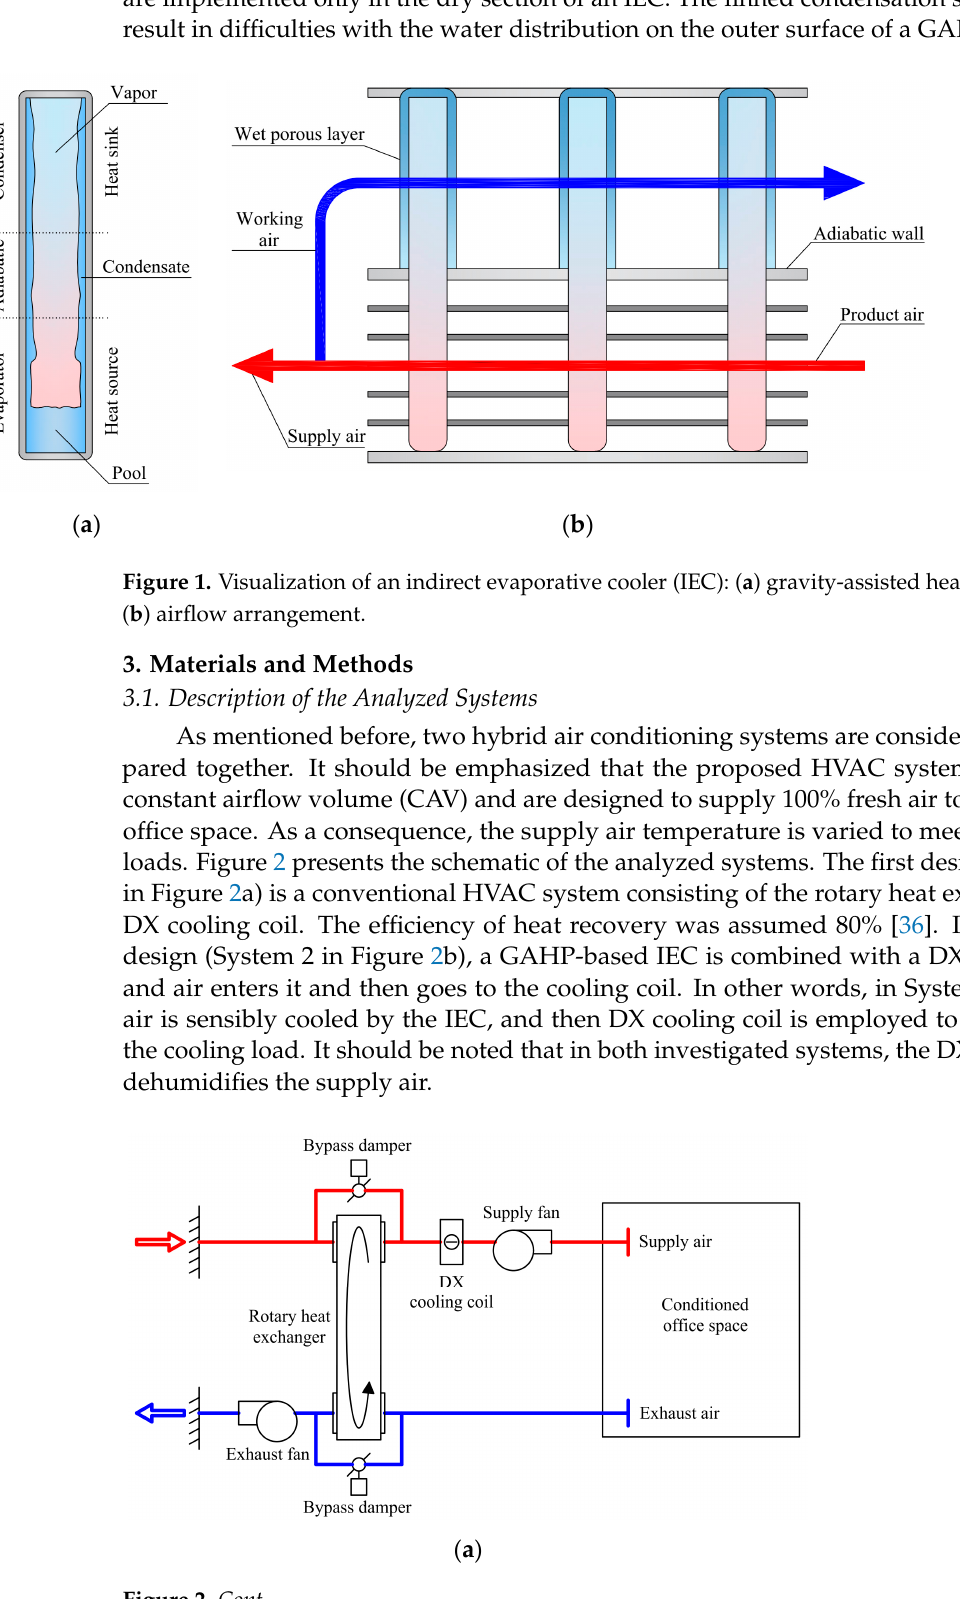
( b ) Figure 2. The schematic of the investigated hybrid air conditioning systems: ( a ) System 1 (rotary heat exchanger and DX cooling coil); ( b ) System 2 (GAHP-based IEC and DX cooling coil). The main design parameters of GAHP-based IEC are listed in Table 2. In the authors’ previous study [32], the most favorable ranges of operating conditions for the GAHP- based IEC were established. On this basis, the geometrical parameters were set in order to ensure the required supply airflow rate to the conditioned space. Table 2. Main design parameters of the GAHP-based IEC. Parameter Value Length × Width × Height 0.45 × 0.90 × 1.25 m Outer diameter of